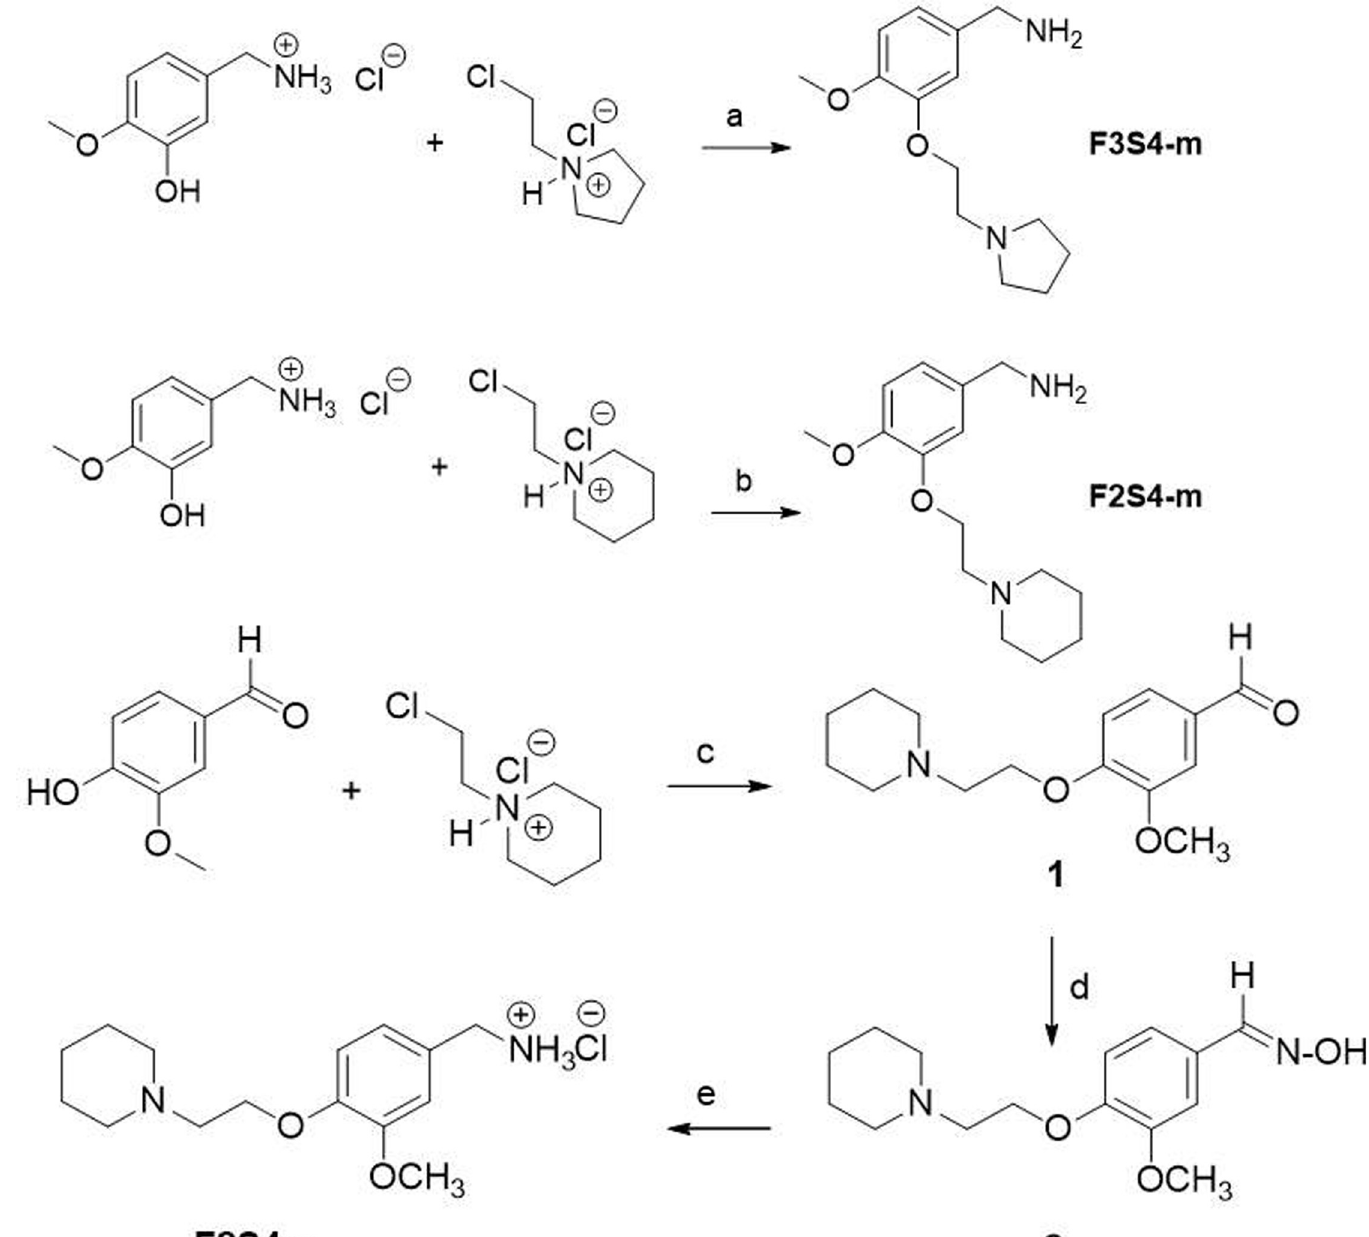
Scheme 1. General reaction for F3S4-m, F2S4-m, and F2S4-p formation. Reagents (K 2 CO 3 , dry acetone) and conditions: (a) reflux 48 h, (b) reflux 12 h, (c) reflux 8 h; (d) NaHCO 3 , EtOH, reflux 4 h; (e) Pd/C 10%, 70 psi, absolute EtOH, 4